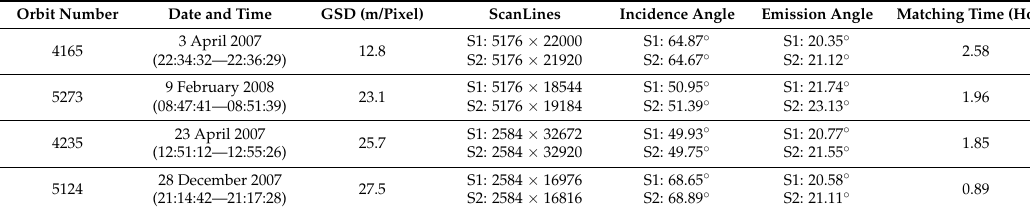
Table 5. Basic information on the experimental datasets. GSD: ground sample